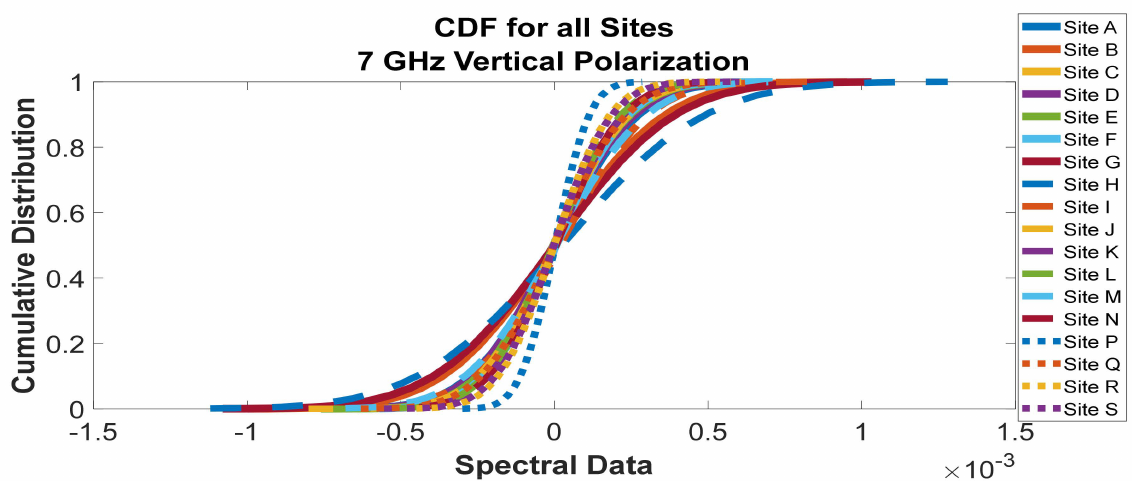
Figure 38. Cumulative distribution functions of frequency scan for all sites at 7 GHz vertical polarization.